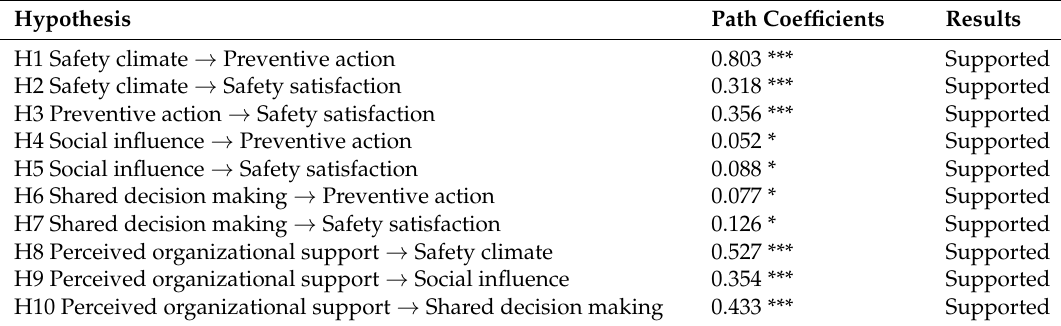
Table 4. Summary of hypotheses validated results.